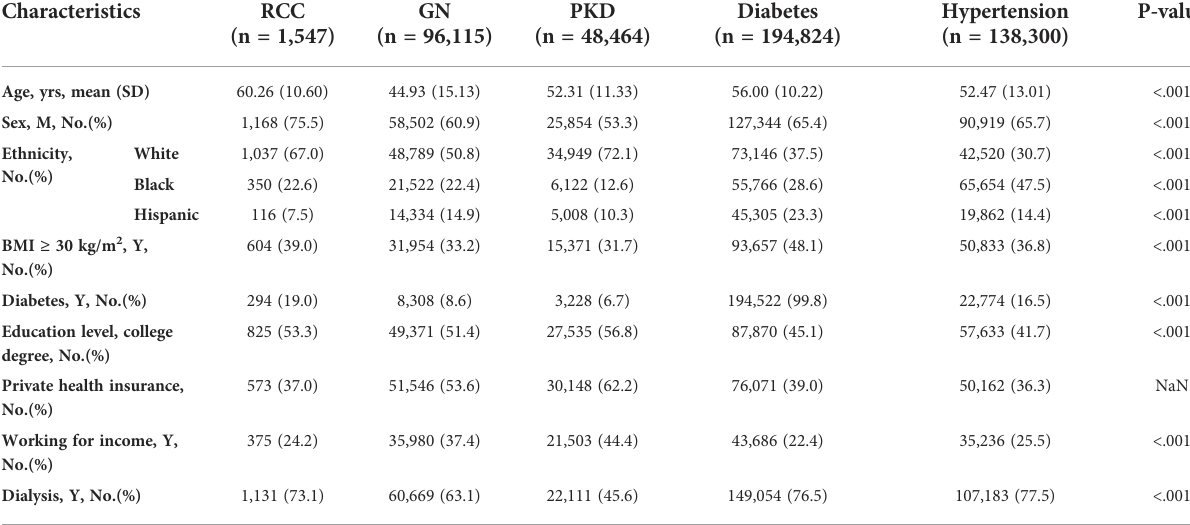
TABLE 1 Candidates ’ characteristics.